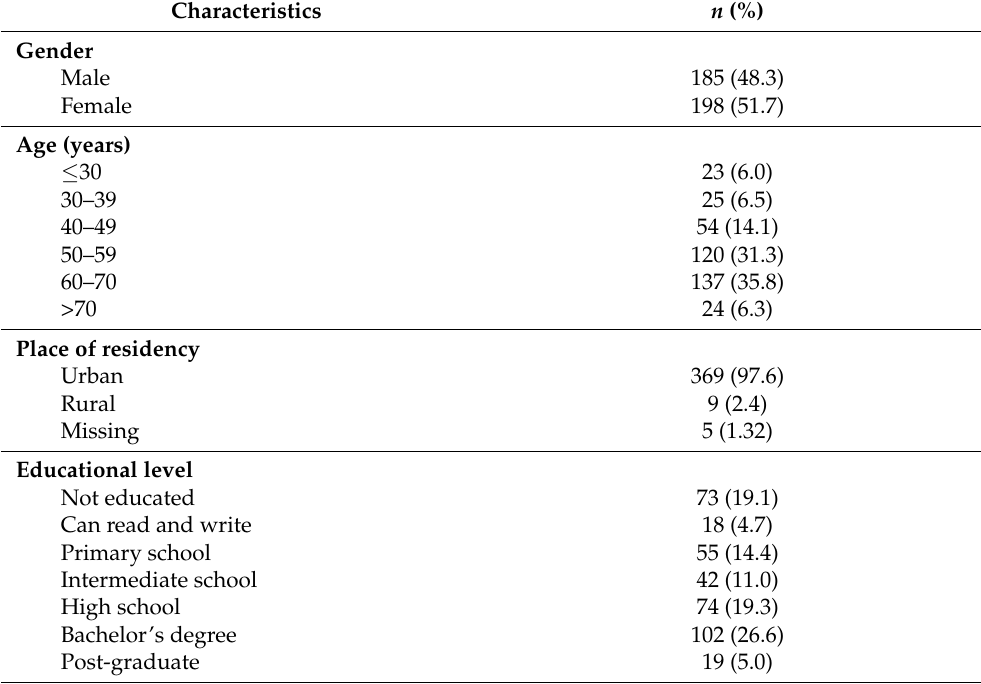
Table 1. Socio-demographics characteristics of the study participants ( n = 383).